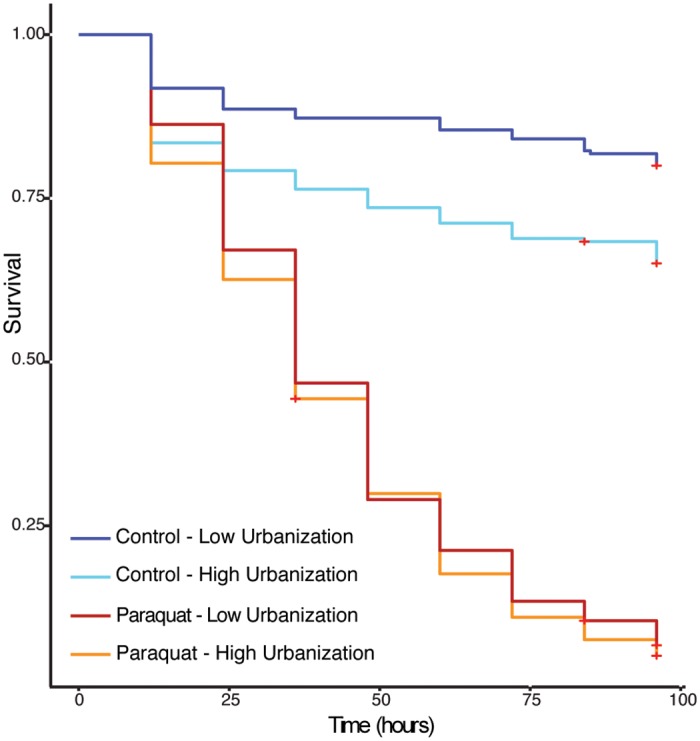
Survival plot of control and paraquat treated bees.Red crosses indicate censored individuals. (Cox model for control bees: p < 0.01; Cox model for paraquat bees: p < 0.05). Although urbanization was analyzed as a continuous variable (percent impervious surface) in the Cox model, it is represented here as two categories for visual clarity; the categories represent sites above and below the median level of urbanization.